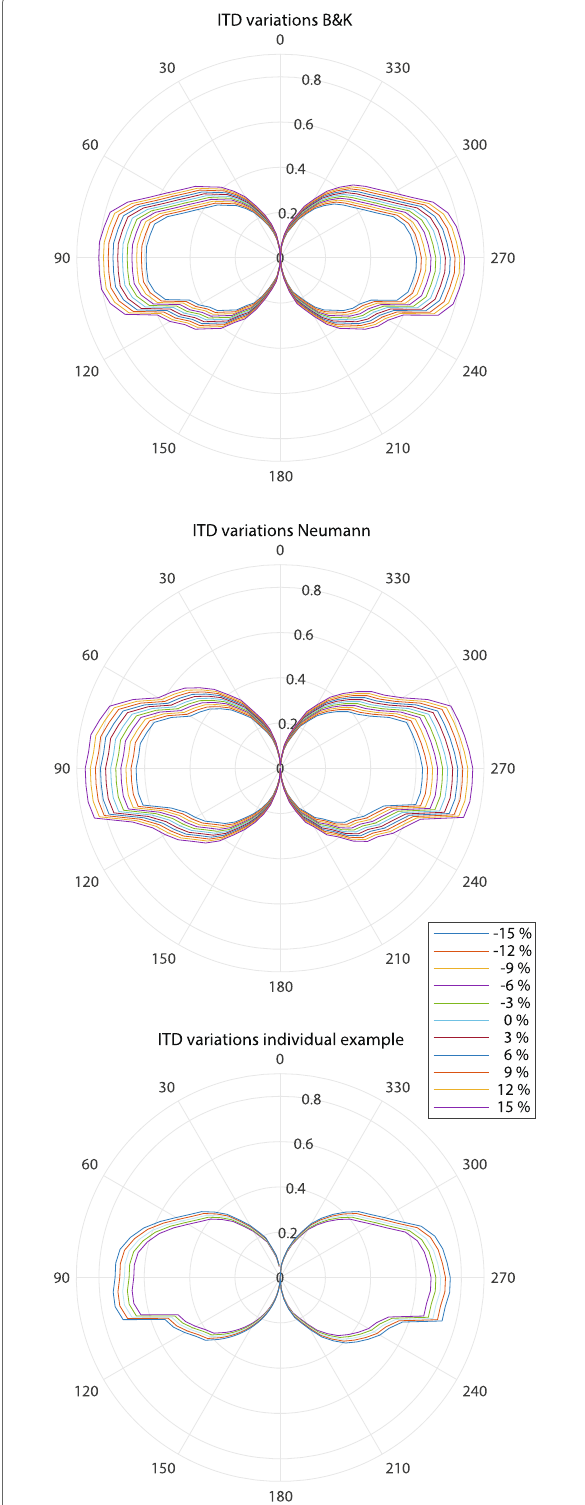
Fig. 4 Scaled ITD of the two dummy heads and one individual example, presented in the exploratory perceptual test. Radial units are in